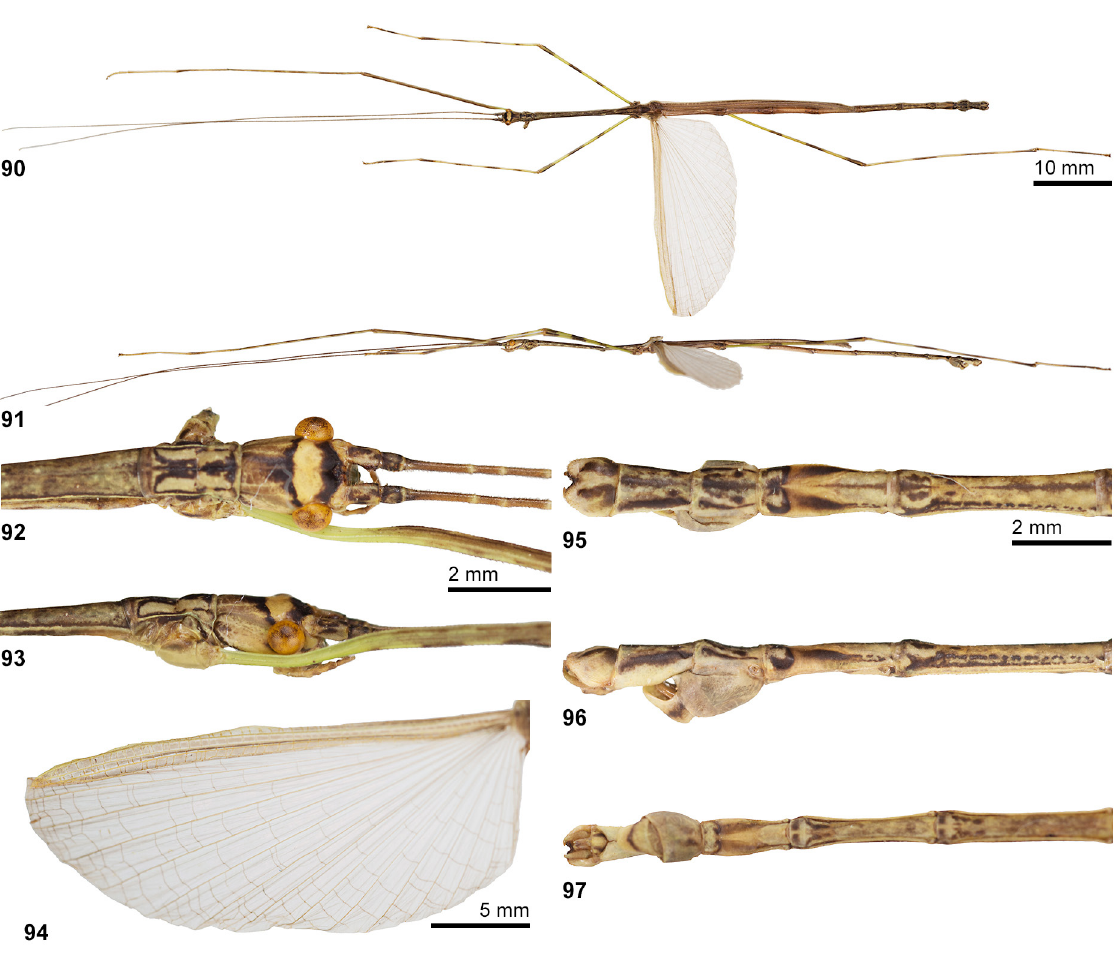
view. 92 . Head and pronotum, dorsal view. 93 . Head and pronotum, lateral view. 94 . Left ala. 95 . Apex of abdomen, dorsal view. 96 . Apex of abdomen, lateral view. 97 . Apex of abdomen, ventral